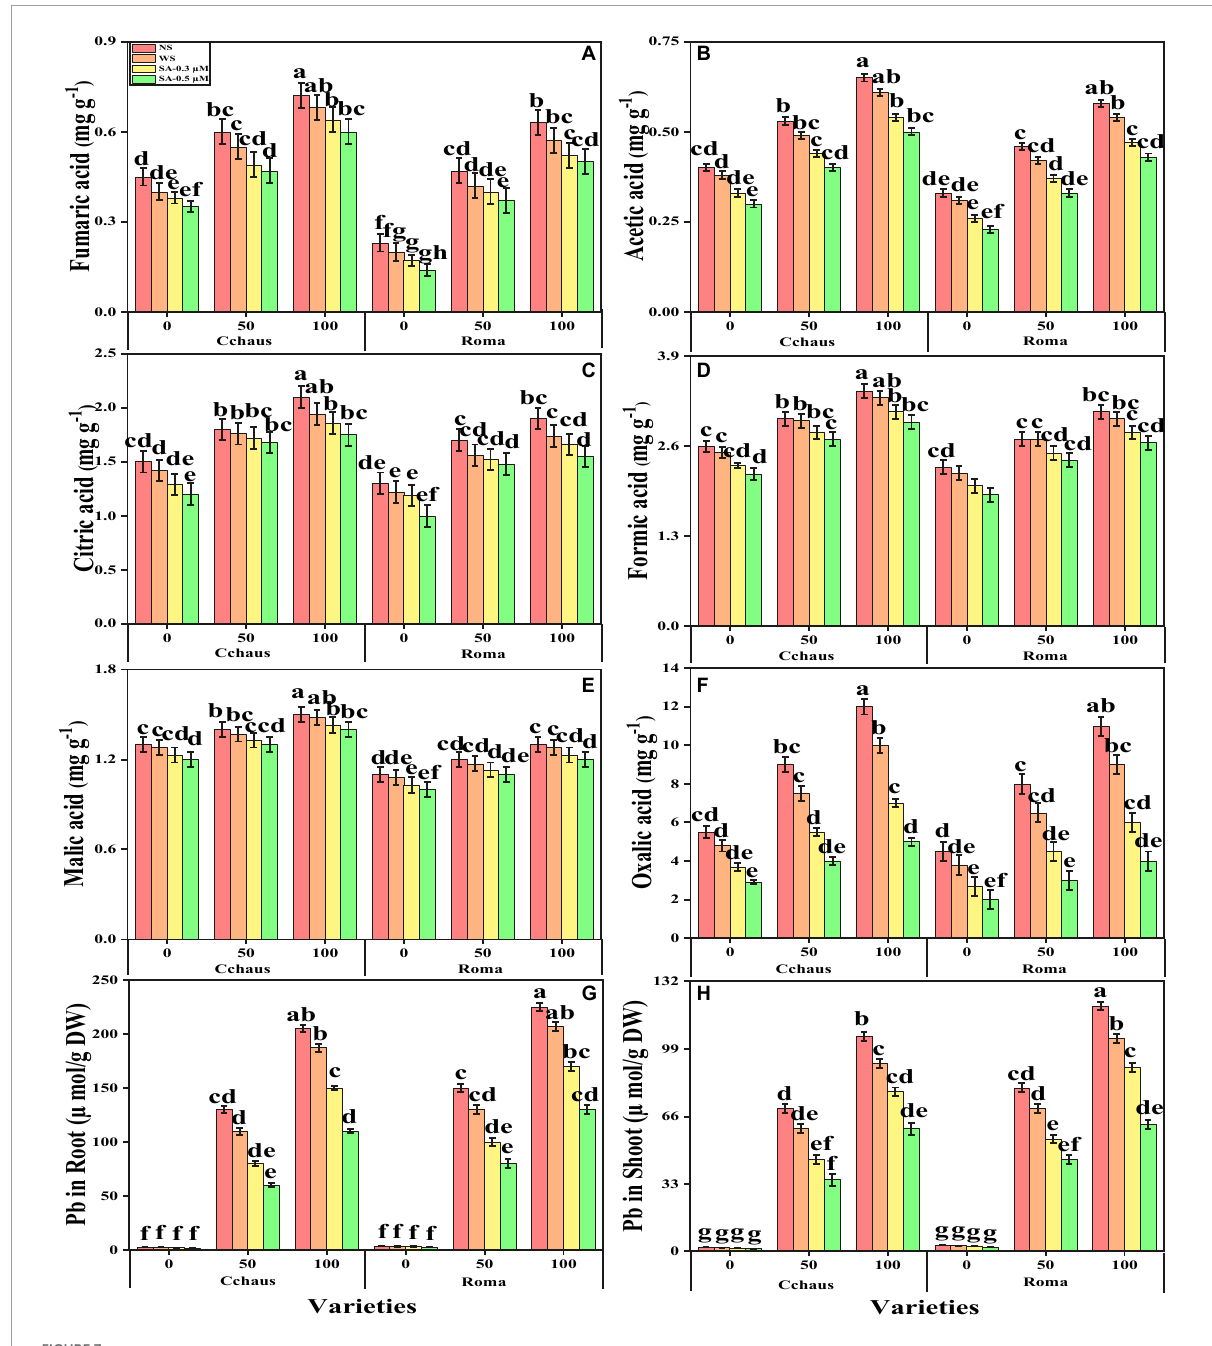
FIGURE7 Effect of exogenously applied syringic acid (0.3-0.5 ◦ µ M) on fumaric acid contents (A) , acetic acid contents (B) , citric acid contents (C) , formic acid contents (D) , malic acid contents (E) , oxalic acid contents (F) , Pb concentration in the roots (G) and Pb concentration in the shoots (H) on Solanum lycopersicum varieties (Cchaus and Roma) cultivated under stress levels of Pb [0 (no Pb), 50 and 100 mg kg − 1 ]. Values are demonstrated as means of four replicates along with standard deviation (SD; n = 4). Two-way ANOVA was performed and means differences were tested by HSD ( P < 0.05) through Tukey’s test. Different lowercase letters on the error bars indicate significant difference between the